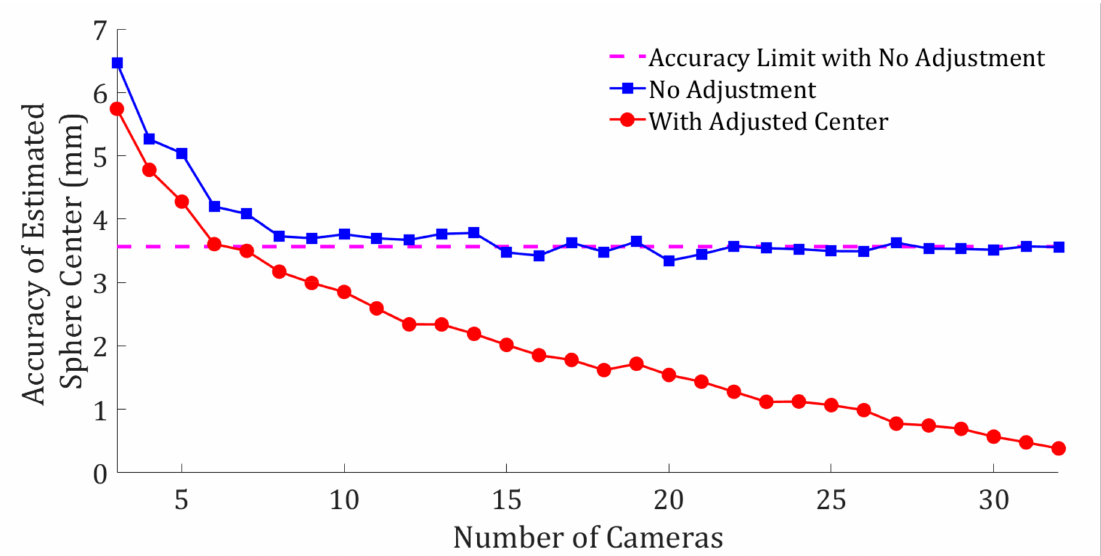
Figure 7. Accuracy of the estimated 3D reconstructed target centers using modeled eccentricity (with adjustment) as well as unmodeled (no adjustment), vs. the number of image